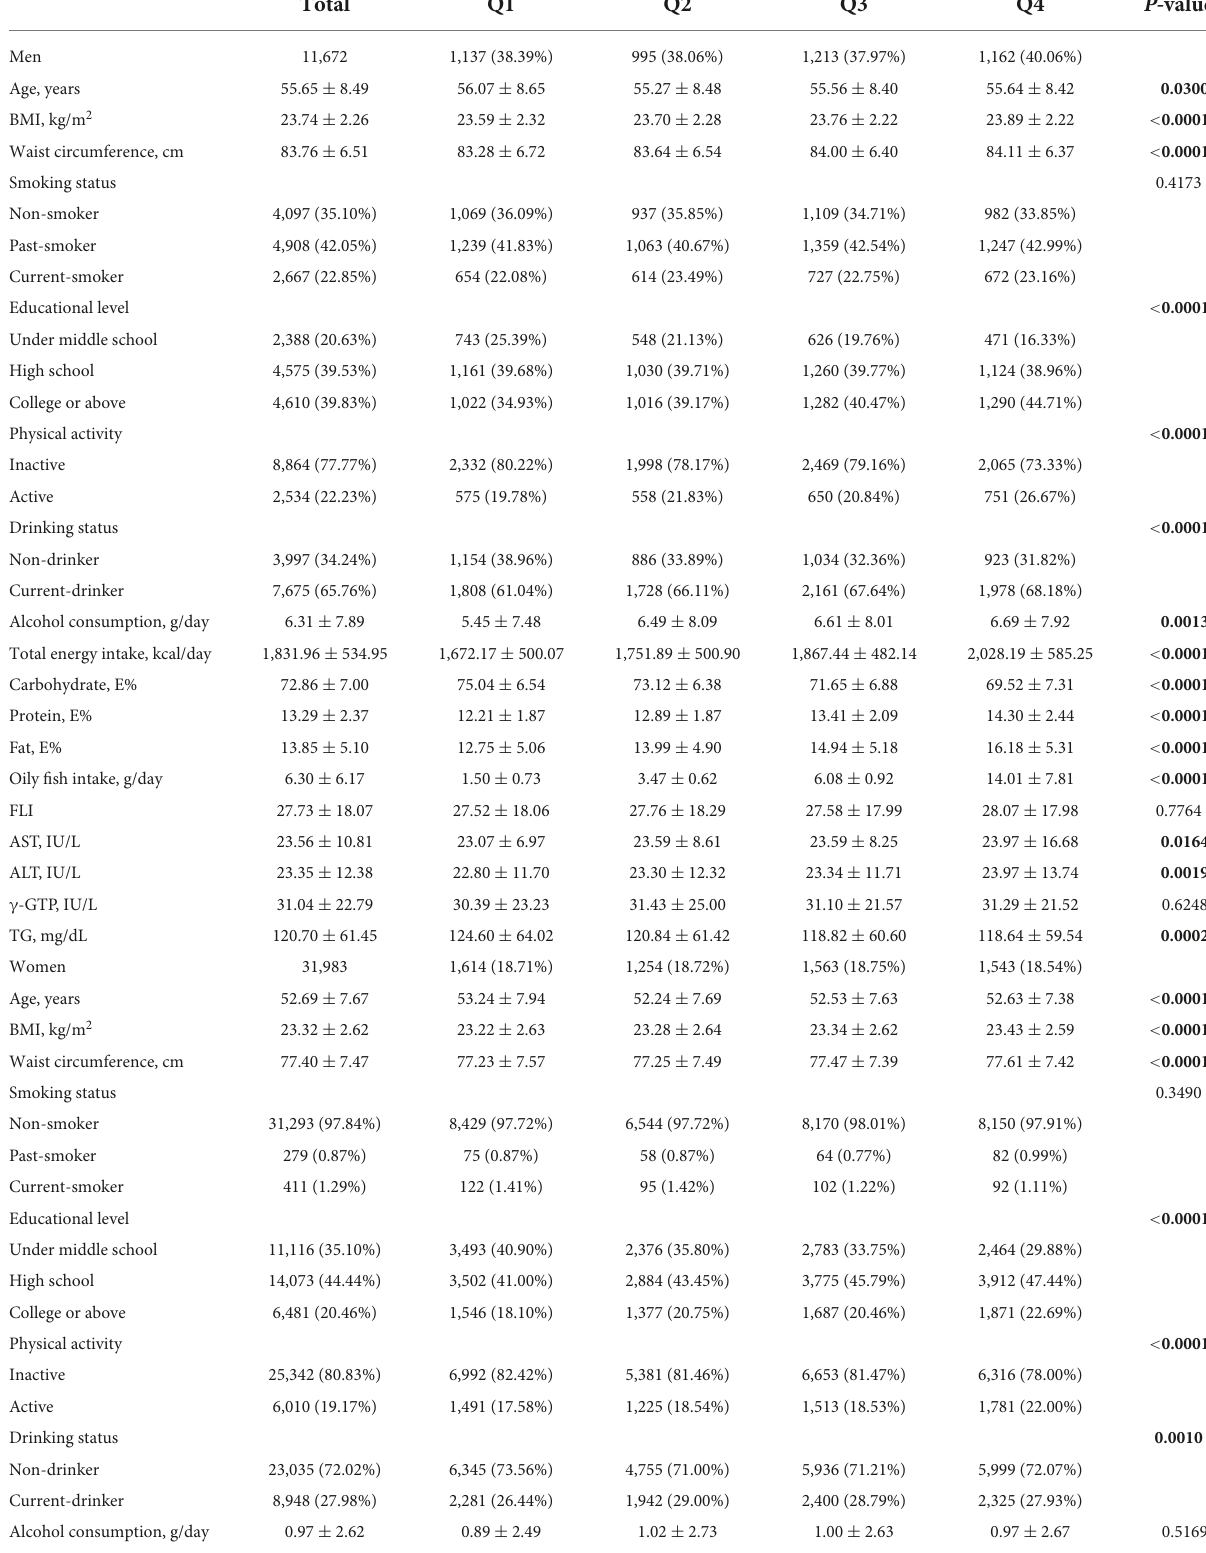
TABLE 1 Baseline general characteristics according to quartiles of oily fish